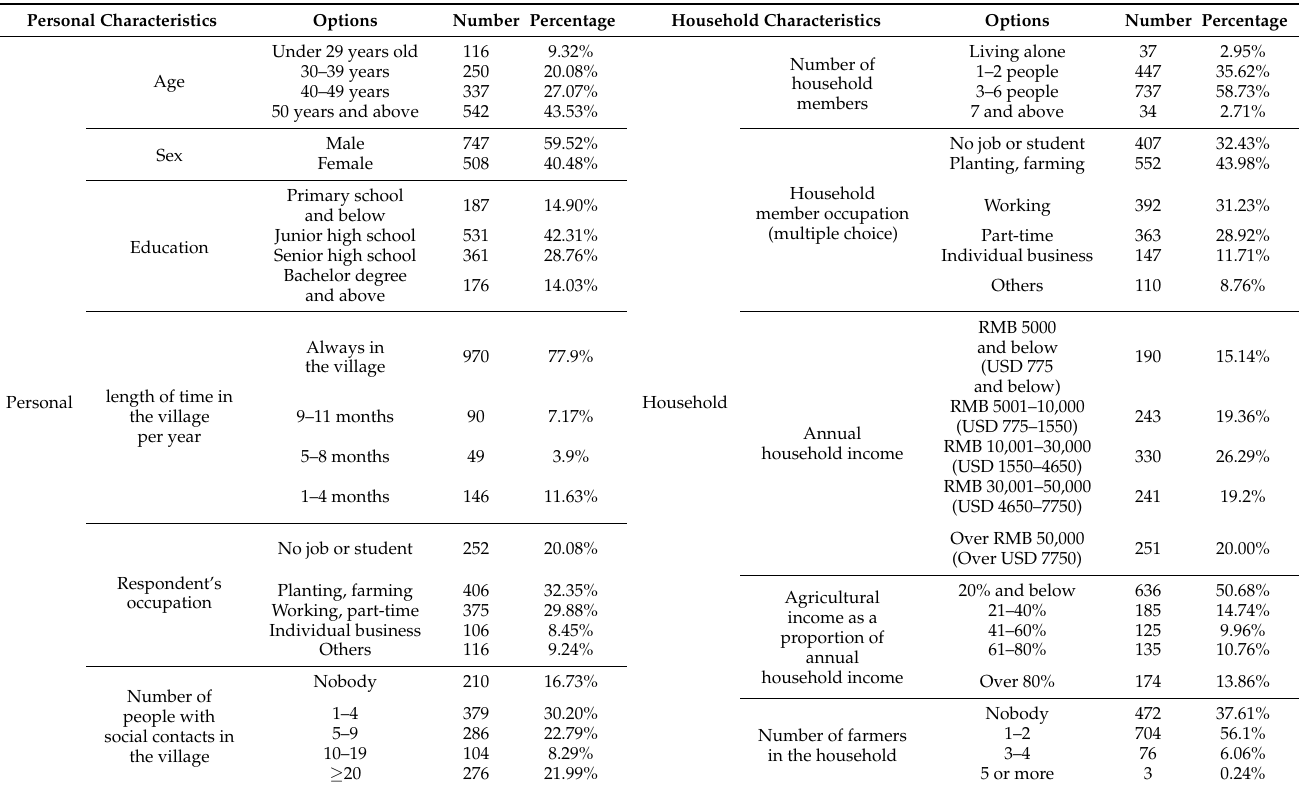
Table 2. Respondents’ personal and household